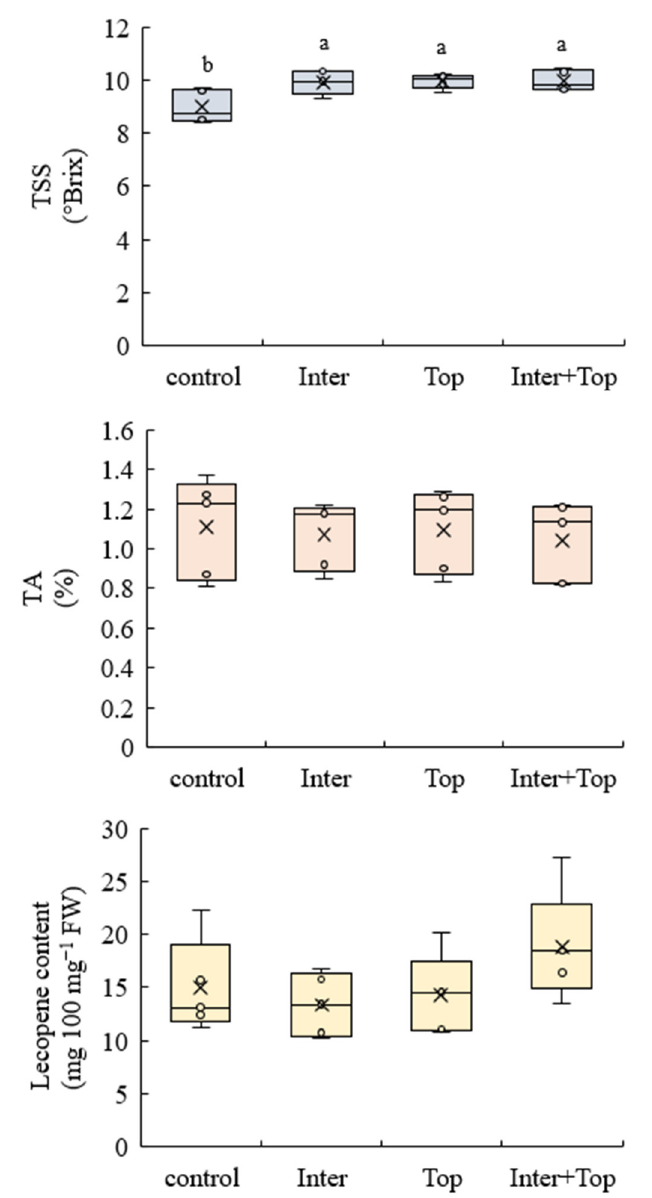
Figure 5. Total soluble solid (TSS), total acidity (TA), and lycopene content under control conditions, without LED SL and with LED SL. Circles, crosses, and dash indicate values for each sample, means, and medians. Different letters indicate significant differences between treatments at p < 0.05 using the Tukey–Kramer test.